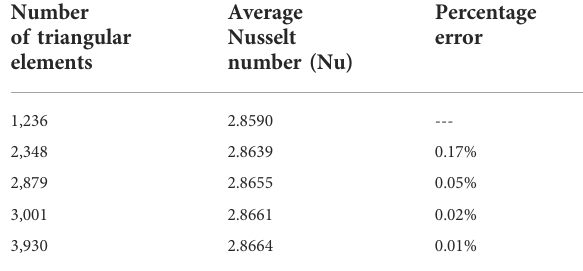
TABLE 1 Grid independent test.